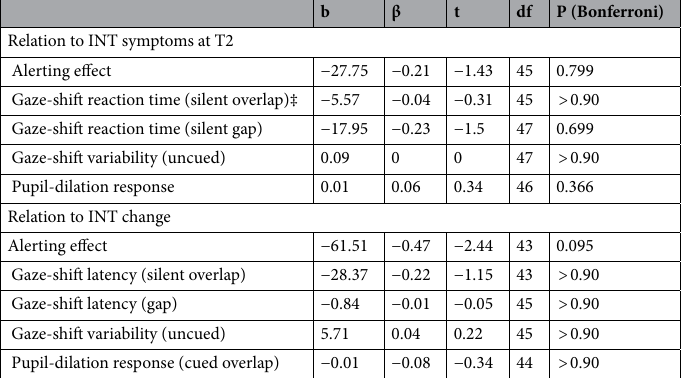
Table 4. Relations between eye-movement measures, internalizing symptoms (INT) at T2 and change in INT symptoms from T1 to T2. INT internalizing symptoms. * p < 0.05 (Bonferroni-corrected). ‡ 1 outlier observation removed. Unstandardized b coefficients indicate the predicted change in MS (gaze shift latency) or pupil size